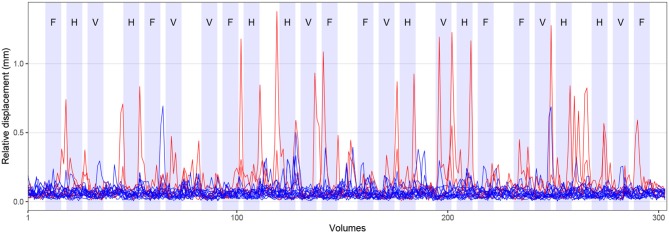
Experimental paradigm and head motion. Blocks of tongue movement are shown in light blue; F: frontal (protrusion), H: horizontal (side to side), and V: vertical (elevation) movements; duration 15 s each. Mean relative displacement, the distance between one volume and the following volume, during all FMRI measurements is displayed with blue (17 included participants) and red lines (three excluded participants). Data from individual participants are superimposed.